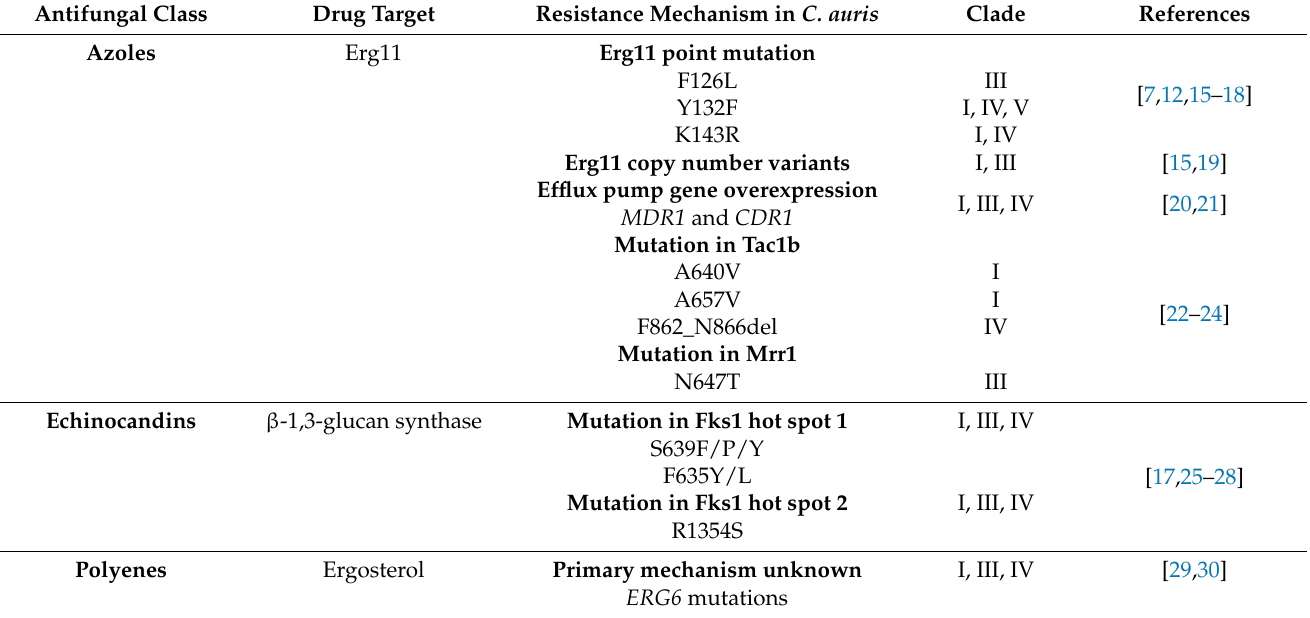
Table 1. Common resistance mechanism in C. auris